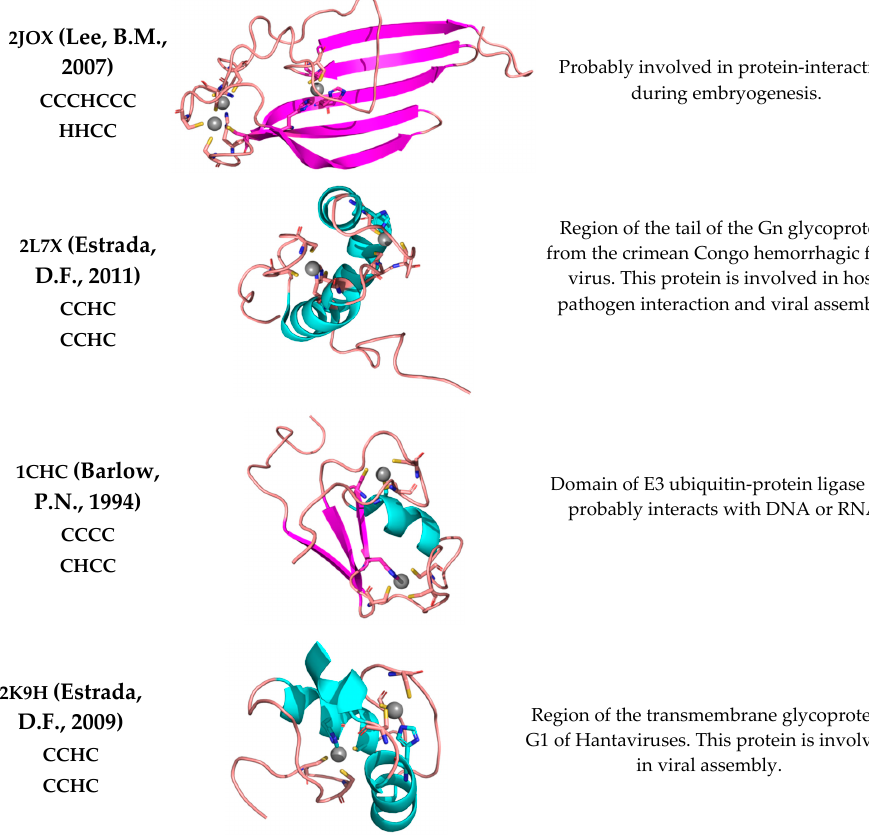
Figure 1. Zinc-fingers used to test the bonded and nonbonded FF. The first column reports the PDB code of the structure together with the amino acid pattern(s) binding the zinc(II) ion(s) [23–28,37,38]. The third column reports information about their biological role. The first protein in our benchmark set is 2NAX. This structure contains seven β strands, a short N-terminal 3 10 -helix and a longer C-terminal α helix (Figure 1). The resi- dues interacting with the zinc(II) ion are Cys 564 and Cys 567 , located on the β 2 β 3-hairpin, and His 596 and Cys 599 on the C-terminal α helix. Figure 2 shows the averaged MD-com- puted S 2 for both FFs superimposed to the Het-NOE data.